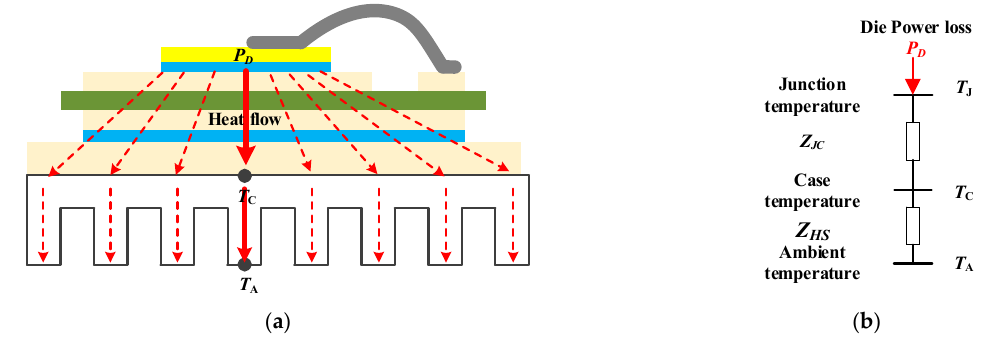
Figure 2. ( a ) Heat flow in healthy module. ( b ) Thermal network of healthy module. The case temperature T C rises when the power loss P loss flows through the heatsink to ambient T A , which is related to the equivalent thermal resistance of heatsink Z E_HS , as in Equation (2).